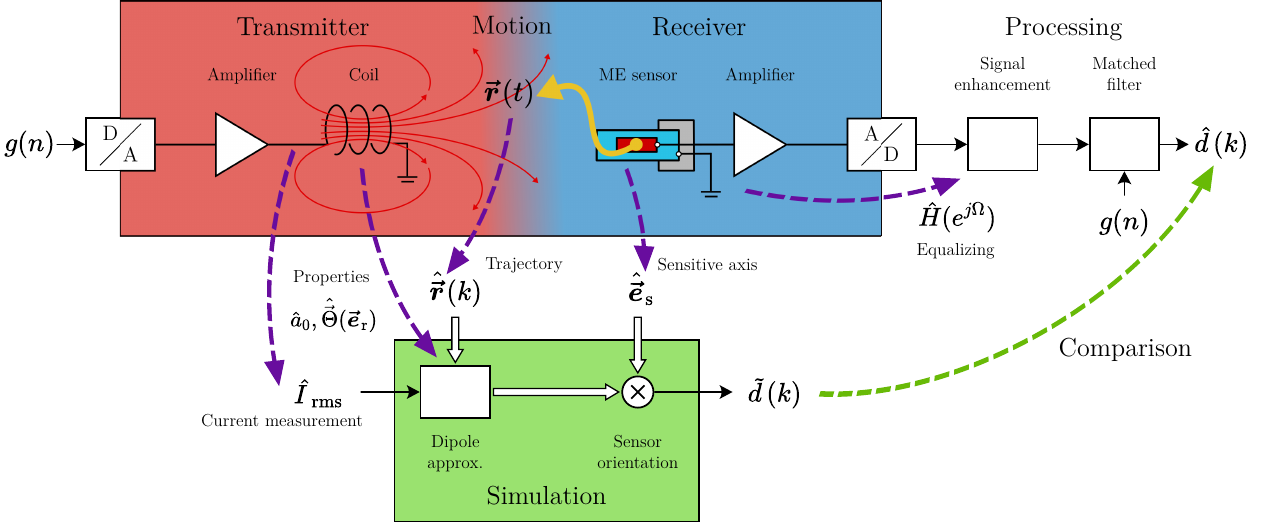
Figure 6. Overall signal chain including